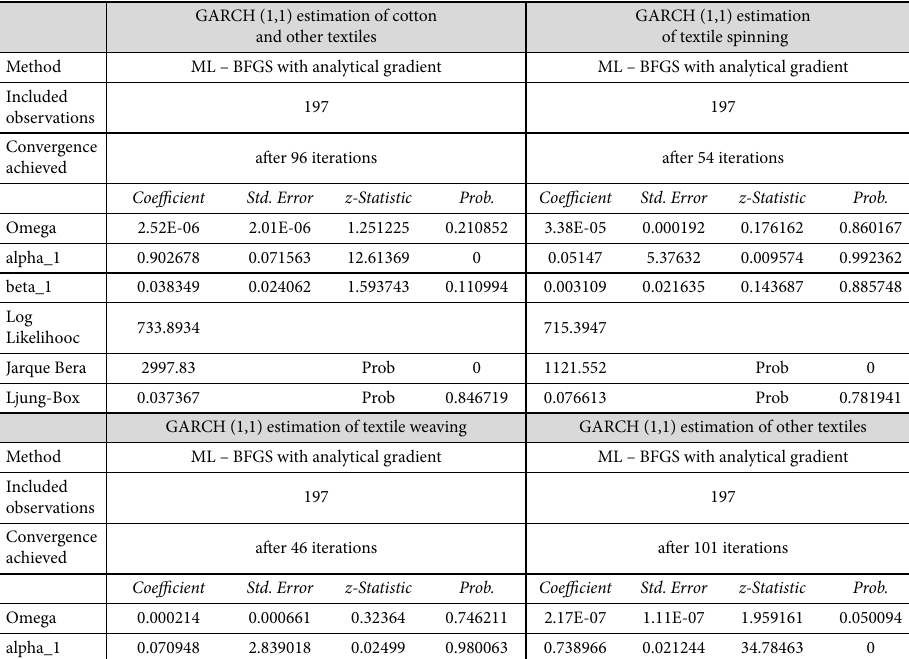
Table 2. GARCH (1,1) output for individual